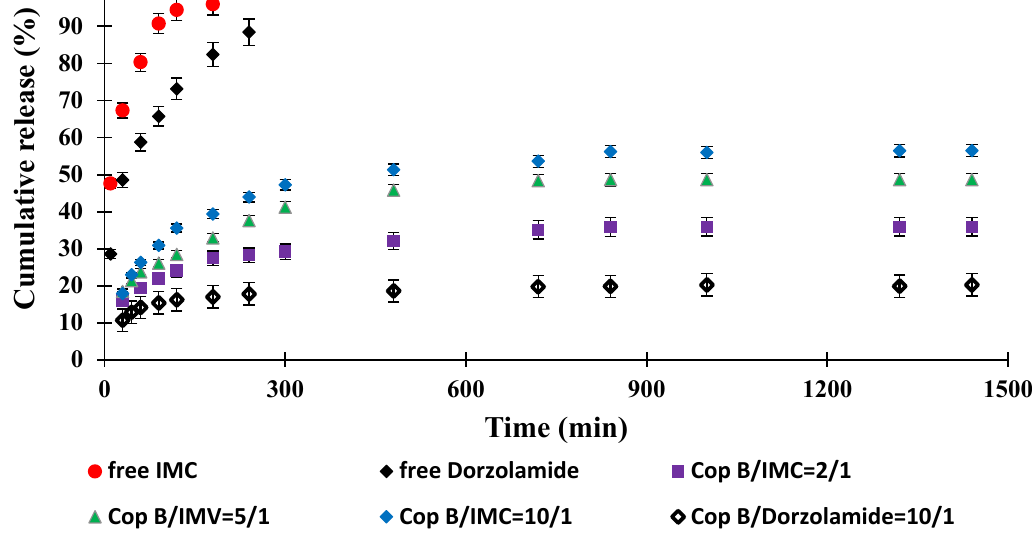
Figure 6. Drug release kinetics in PBS (pH = 7.4) at 37 °C.